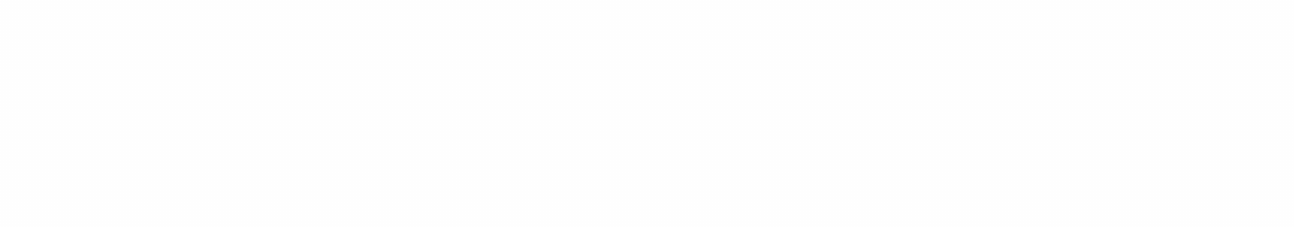
FIGURE 4 Bioeconomic equilibria: Backward-bending sup- ply and shifting